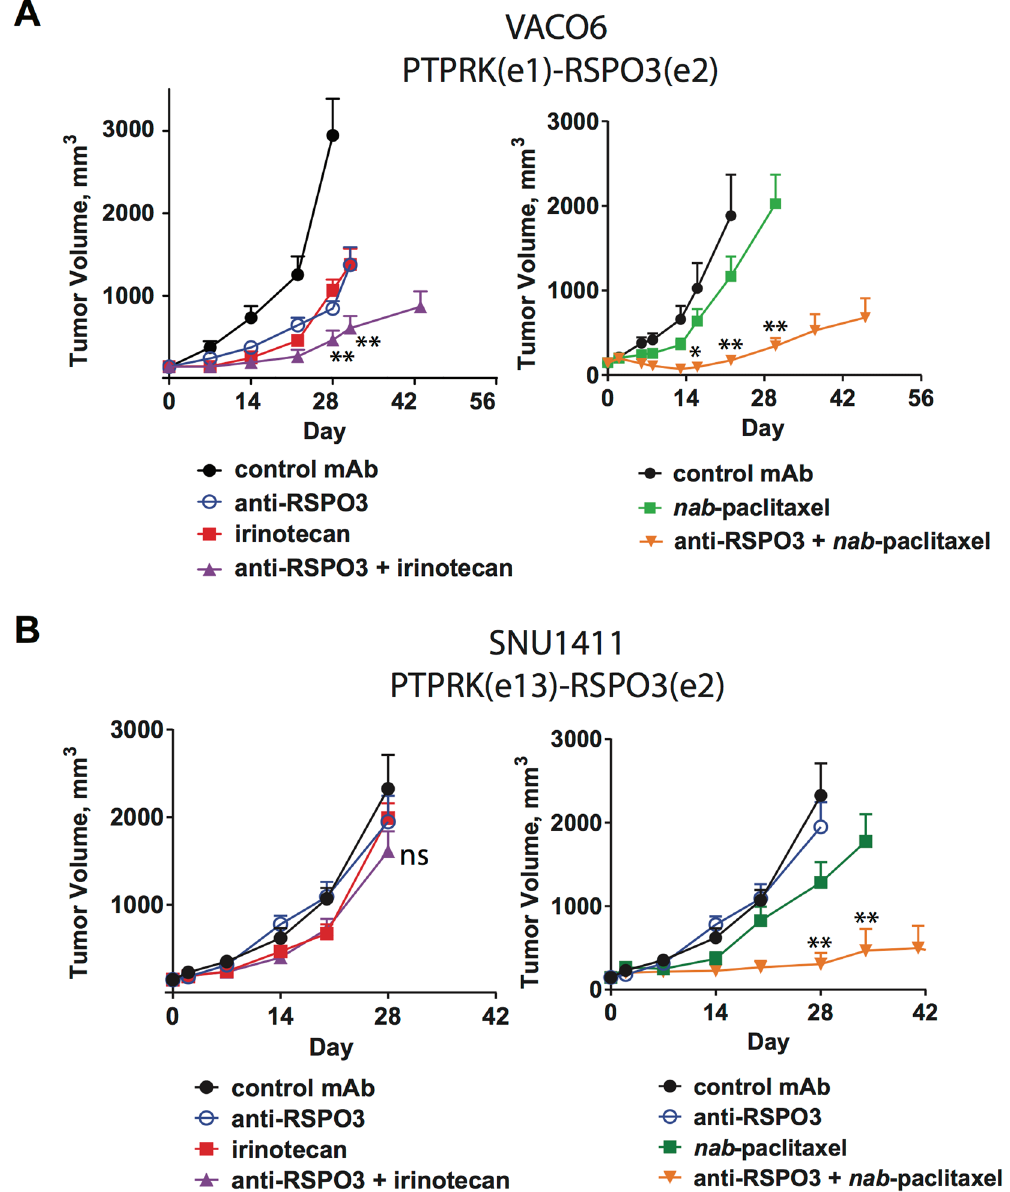
Figure 1. CRC with PTPRK-RSPO3 fusions respond to RSPO3-taxane treatment. ( A ) VACO6 cell line is responsive to irinotecan and nab -paclitaxel when combined with RSPO3 neutralizing antibody anti-Rspo3. ( B ) SNU1411 is non-responsive to anti-Rspo3, irinotecan, or anti-Rspo3 + irinotecan. SNU1411 can be sensitized to nab -paclitaxel when combined with anti-Rspo3. Anti-Rspo3 was dosed at 25 mpk Q2W on day 1, irinotecan was dosed at 10 mpk Q1W on days 3 and 10, and nab -paclitaxel was dosed at 25 mpk Q2W on day 3, 7–10 mice per treatment group. * p < 0.01 vs. nab -paclitaxel, ** p < 0.001 vs. nab -paclitaxel, ns = not